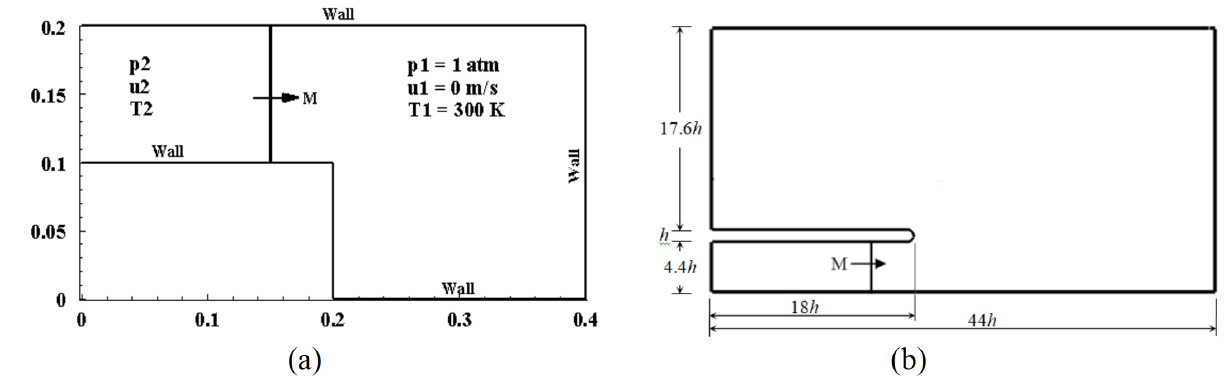
Fig. 1. Geometry and flow conditions (a) Backward-facing step; (b)